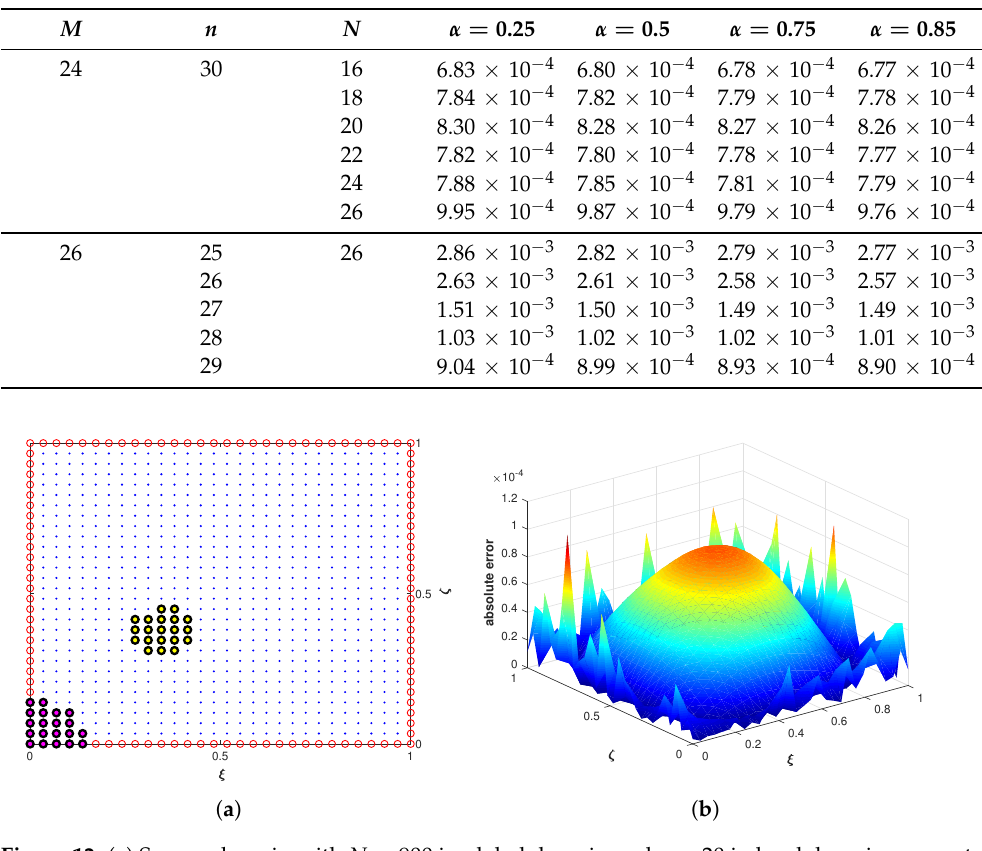
Figure 12. ( a ) Square domain with N = 900 in global domain and n = 20 in local domain, magenta corresponds to boundary and yellow corresponds to interior nodes. ( b ) Absolute error of Problem 4 with α = 0.85, N = 900, n = 30, and M = 28.